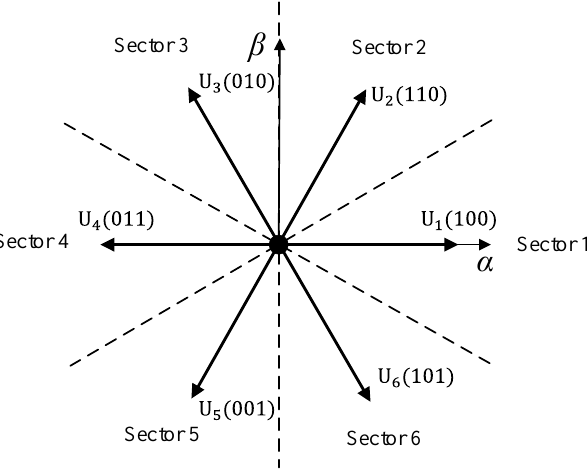
Figure 2. Voltage vectors in conventional DTC.